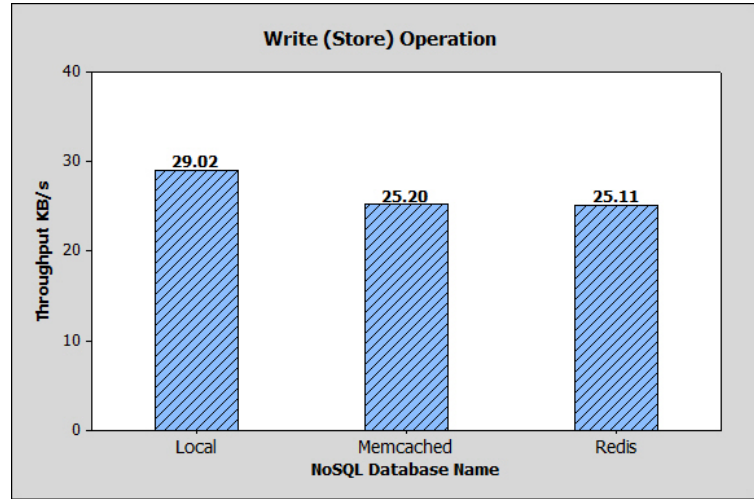
Figure 5. Throughput with write operation (Single